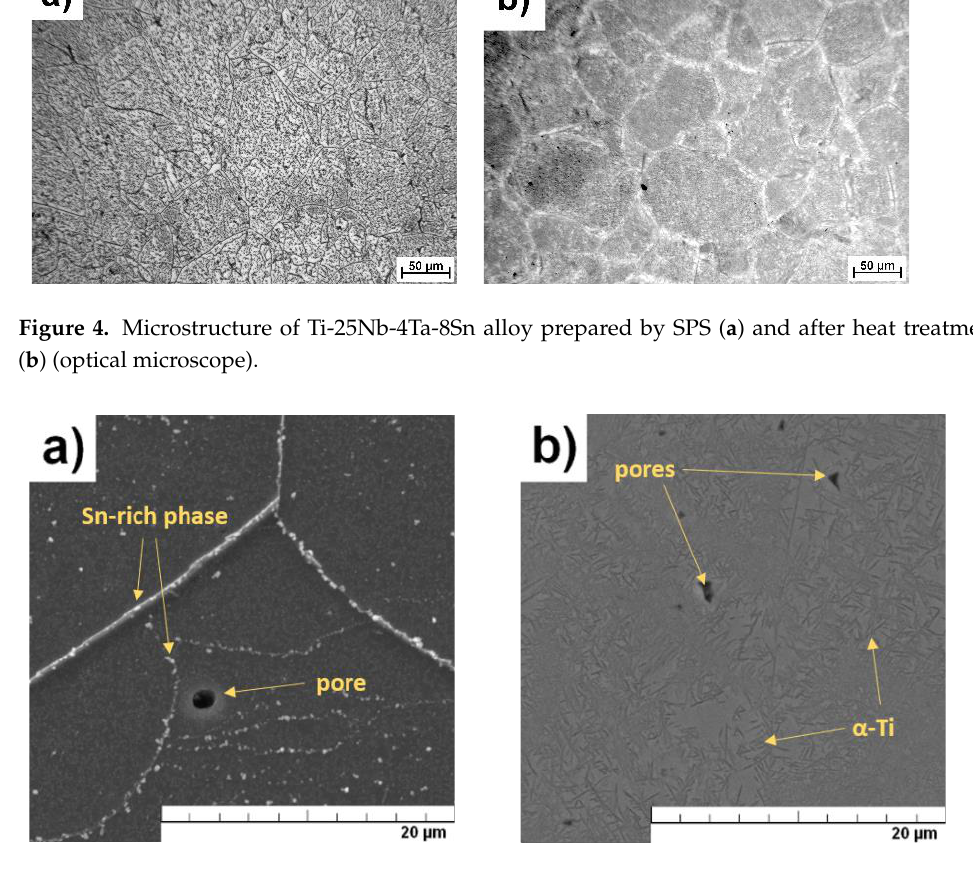
Figure 5. Microstructure of Ti-25Nb-4Ta-8Sn alloy prepared by SPS ( a ) and after heat treatment ( b ) (SEM).